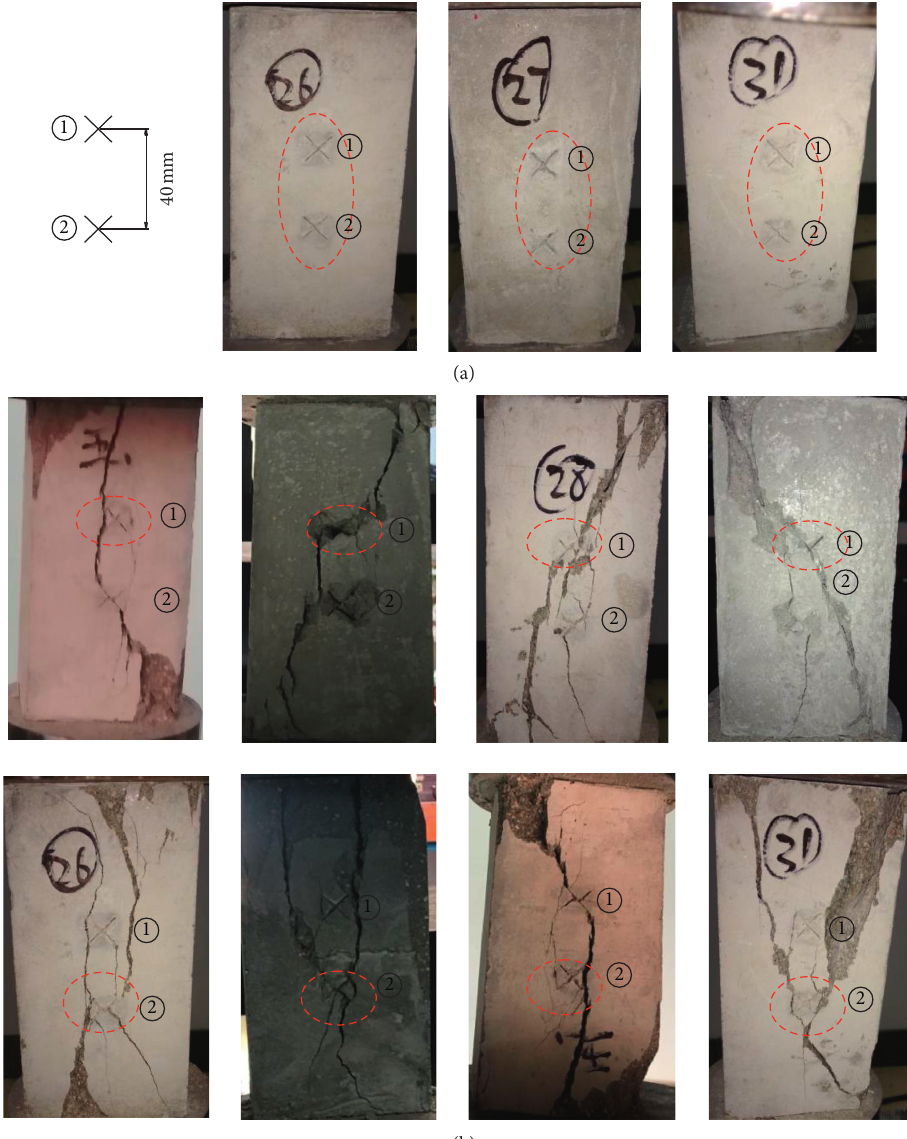
Figure 7: Tests on failure process of rock-like specimens made with double “X” fractures. (a) Sketchy model and parts of rock-like specimens made with double “X” fractures. (b) Failure modes of specimens with double “X”